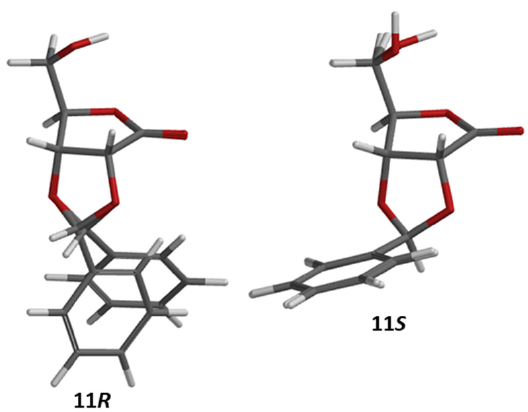
Figure 2. Lower energy conformer calculated in DMSO at 298 K, of 12 R (>99% of population) and 12 S (>99% of population).